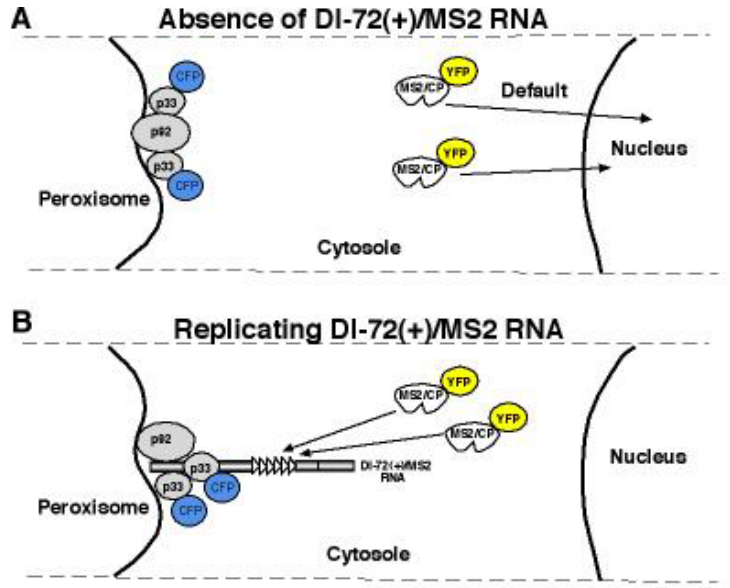
Figure 4. Different subcellular localization of plus- and minus-stranded DI-72 RNA during replication in yeast. (A) Schematic presentation of subcellular localization of MS2/CP-YFP and CFP-p33 in yeast in the absence of viral RNA and (B) in the presence of DI-72(+)/MS2. Specific interaction between the MS2 CP and the MS2 CP recognition hairpin (present in six copies in DI-72(+)/MS2) should result in re-localization of MS2 CP as shown. (C) Co-localization of CFP-tagged p33 and the YFP-tagged MS2/CP bound to the DI-72(+)/MS2 RNA in yeast cells using epifluorescence microscopy. Note that DI-72(-)/MS2 RNA (bottom panel) contains the six copies of MS2 CP recognition hairpins in complementary orientation. Therefore, MS2/CP-YFP could only bind to the negative- stranded DI RNA, which is generated during the replication of DI-72(-)/MS2